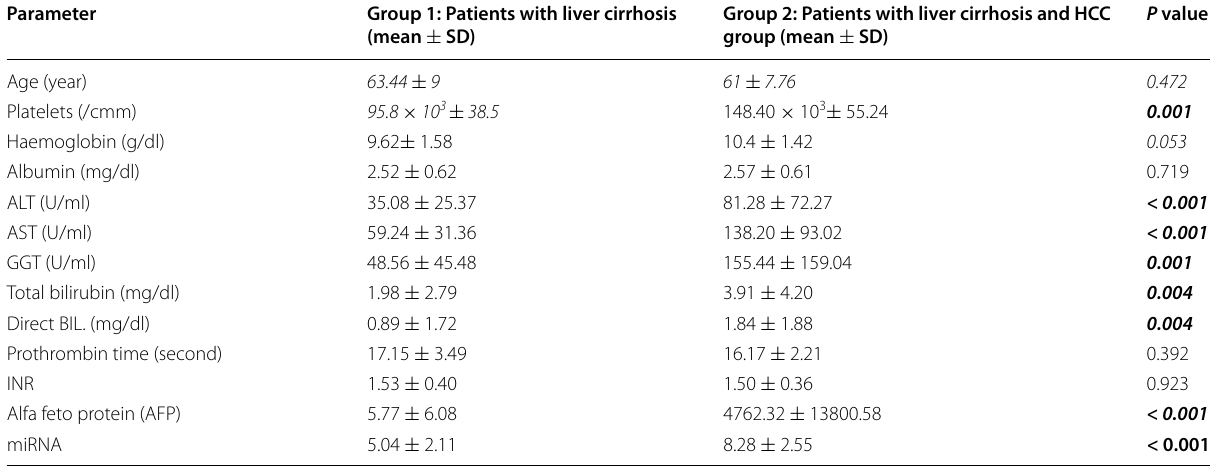
P values <0.05 were considered statistically significant